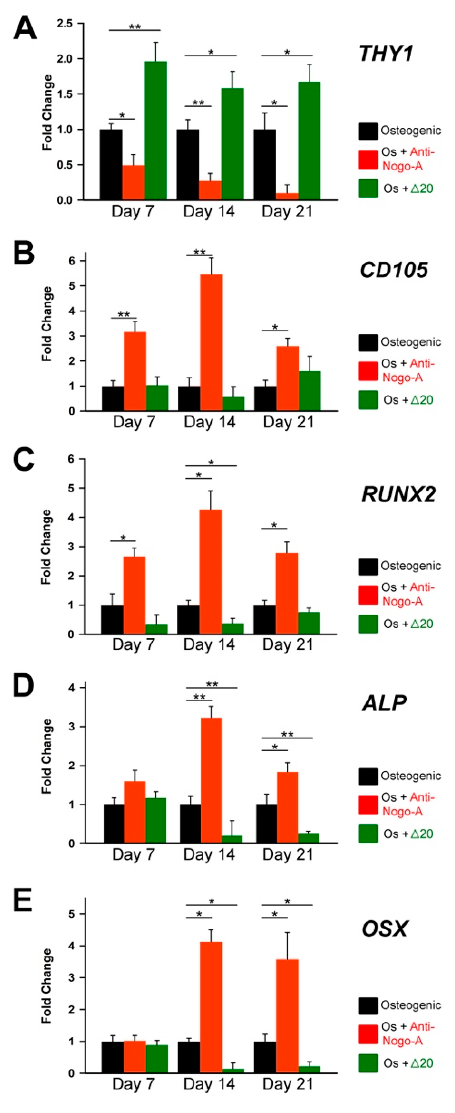
Figure 5. Effects the Nogo-A protein and anti-Nogo-A antibody on the expression of genes during hDPSCs osteogenic differentiation. qRT-PCR analysis showing THY1/CD90 ( A ), END/CD105 ( B ), RUNX2 ( C ), ALP ( D ), and SP7/OSX ( E ) expression levels in hDPSCs cultured in osteogenic medium (Os) alone (black columns), in osteogenic medium supplemented with the anti-Nogo-A-antibody (red colored columns), and osteogenic medium supplemented with the Nogo-A Δ 20 protein (green colored columns) for 7, 14 and 21 days. Values, normalized to Glyceraldaeyde-3-Phosphate Dehy- drogenase (GAPDH), shown are the mean ± SD of triplicates. Statistical analysis used Student’s t - test (significant difference at *, p < 0.05; **, p < 0.01).